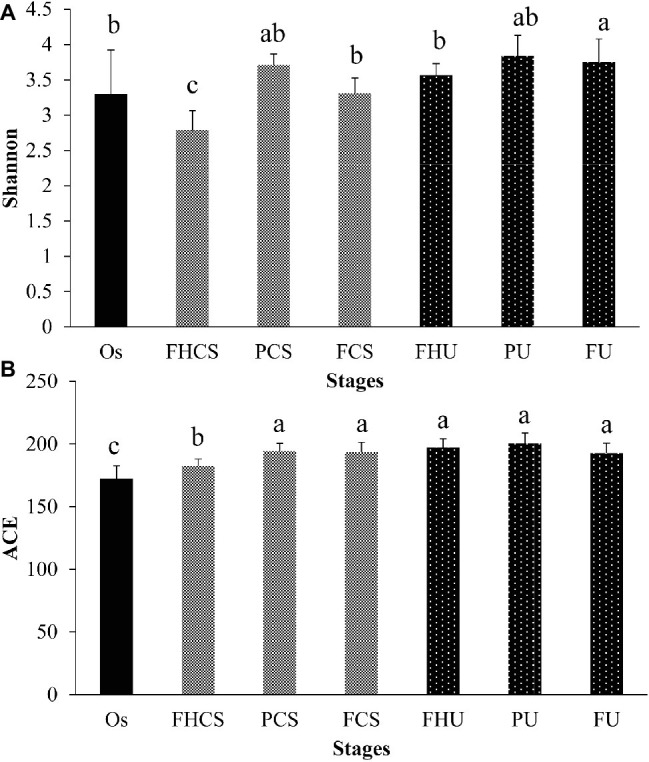
Microbial diversity and richness. The Shannon and ACE indices were calculated at a depth of 7,096 reads in each sample. The bars indicate the mean; the error bars denote standard deviation; and the lowercase letters above the bars indicate significant differences. FHCS, casing soil from stage V (casing soil completely colonized by hyphae); PCS, casing soil from stage VI (primordial stage); FCS, casing soil from stage VII (fruiting body stage); FHU, upper portion of the substrates from stage V; PU, upper portion of the substrates from stage VI; FU, upper portion of the substrates from stage VII. (A) Shannon, (B) ACE.